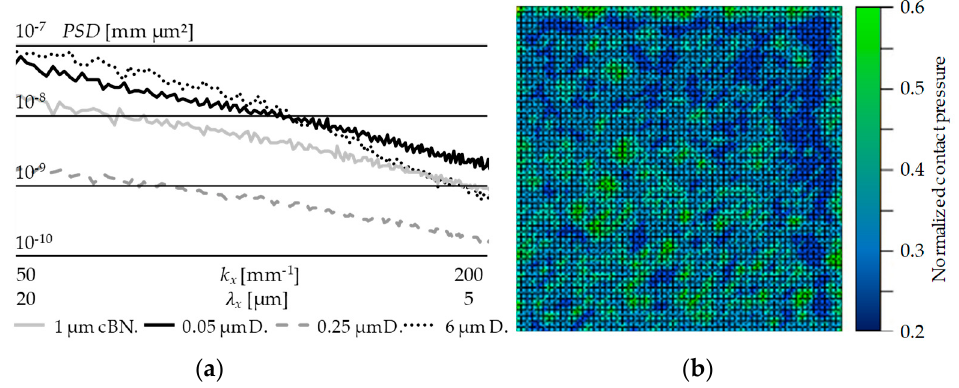
Figure 22. ( a ) PSD (Power spectral density) progressions for different surface finishings; ( b ) First attempts of FEM simulation using realistic surface profiles of Glassy Carbon surfaces in Fused Silica contact.